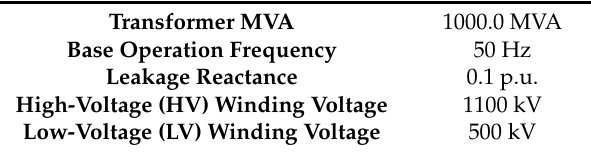
Figure 6. Single line diagram of the simulation model in PSCAD. Table 1. Parameters of the transformer at bus M.